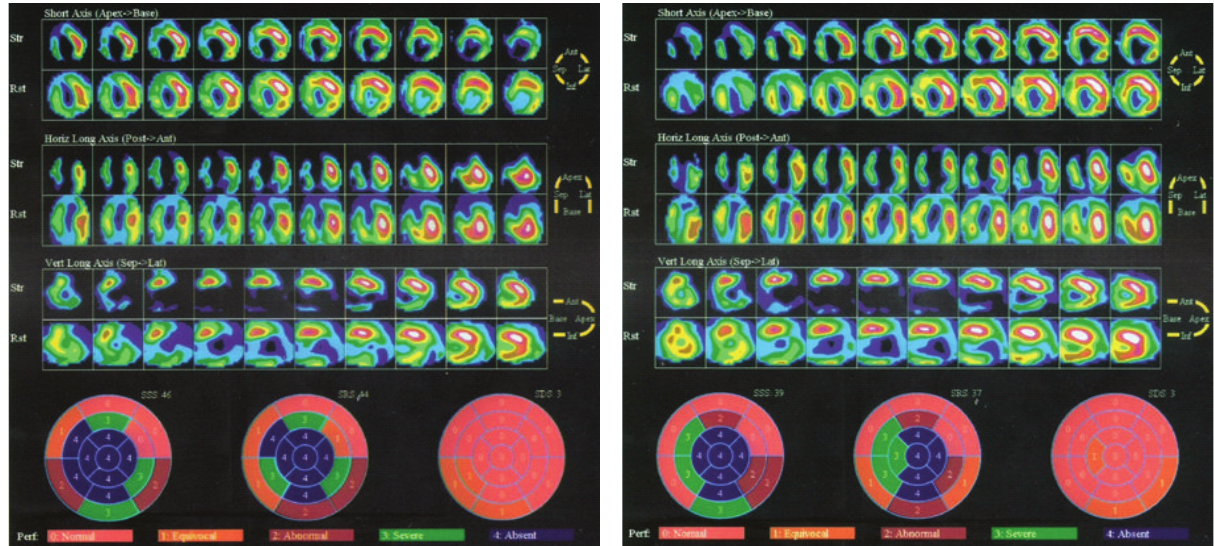
Figure 4: Myocardial perfusion. Left and right panel represent pre- and post-stem cell implantation status, respectively. Upper panels are visual interpretation that comprise short axis view, horizontal long axis view, and vertical long axis view during stress (Str) and rest (Rst). Lower panels are semiquantitative interpretation. Post-stem cell implantation shows more massive perfused myocard as presented with green and yellow color. Semiquantitative interpretation shows less area with score of 4 meaning less area with absent perfusion or nonviable cells. The Summed Stress Score (SSS) and Summed Rest Score (SRS) reduced after stem cell